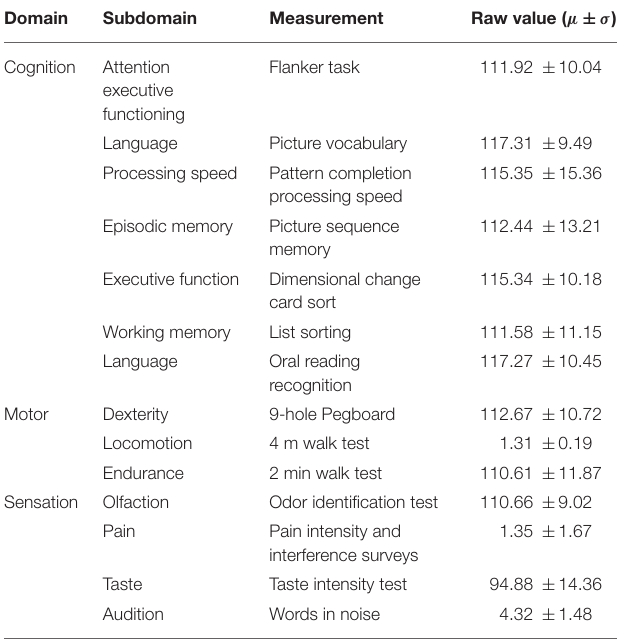
TABLE 1 | Brief description of neuro-behavioral measures from the NIH